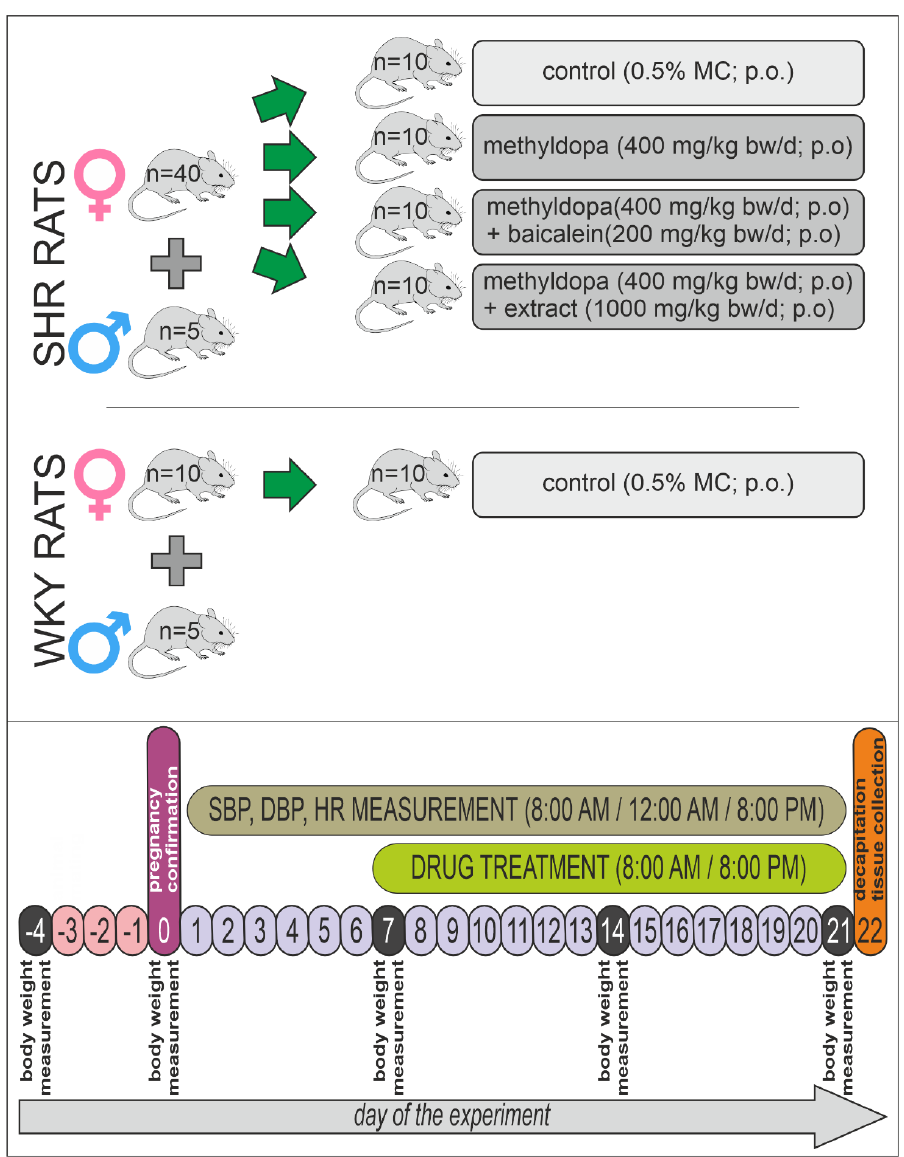
Figure 14. Graphical presentation of the animal experiment scheme.